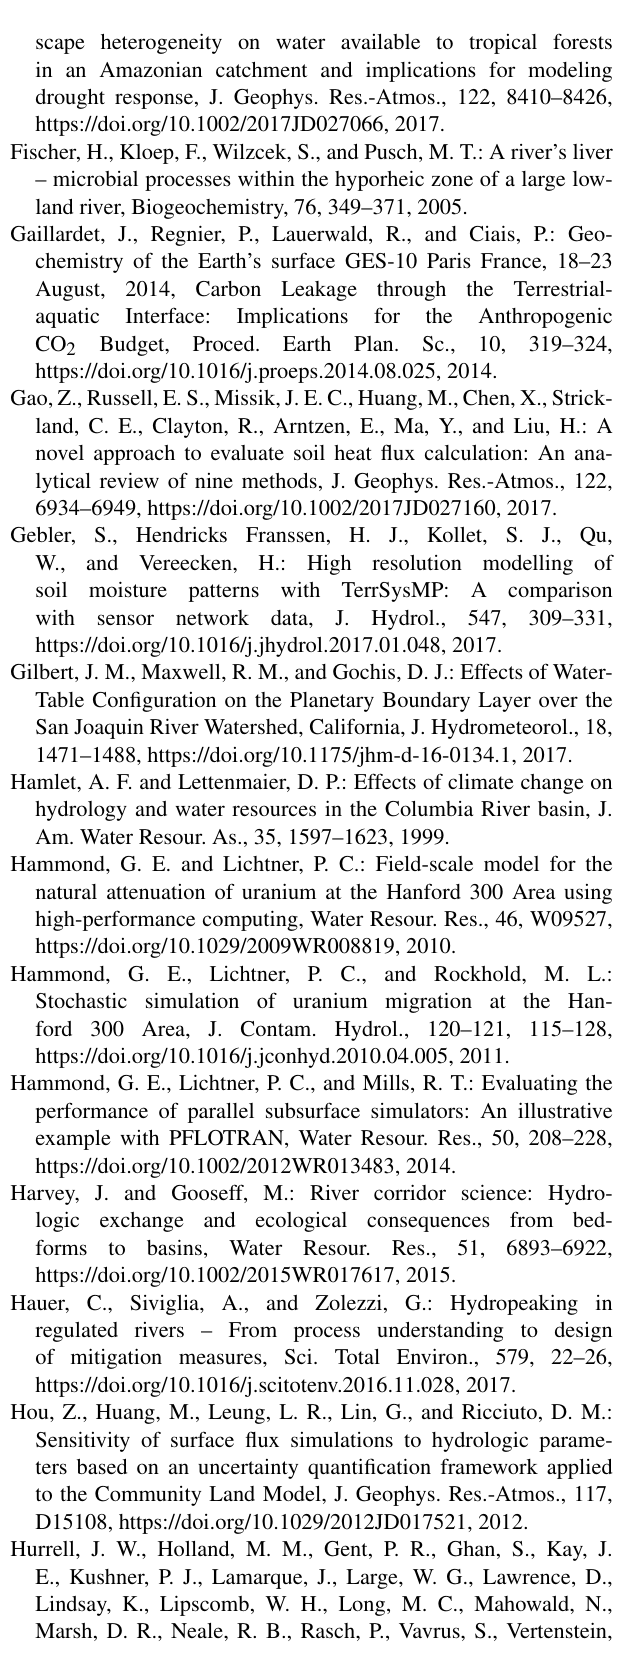
Table Configuration on the Planetary Boundary Layer over